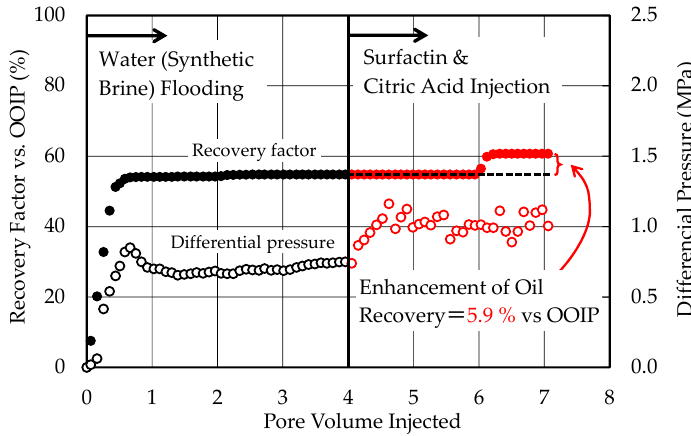
Figure 7. Temporal change in the recovery factor and di ff erential pressure during the core flooding experiment using less permeable oil reservoir.